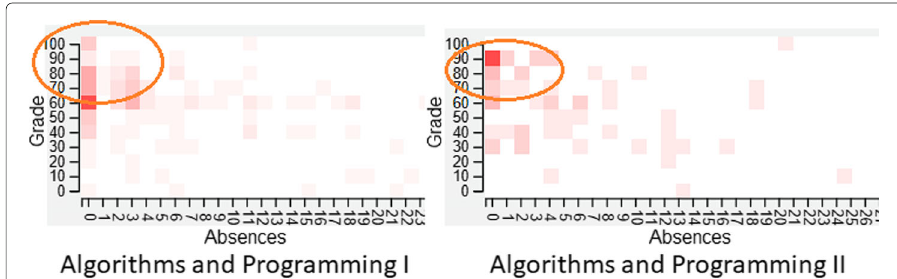
Fig. 10 Attendance vs. grade Heatmap Matrices for "Algorithms and Programming I" and "Algorithms and